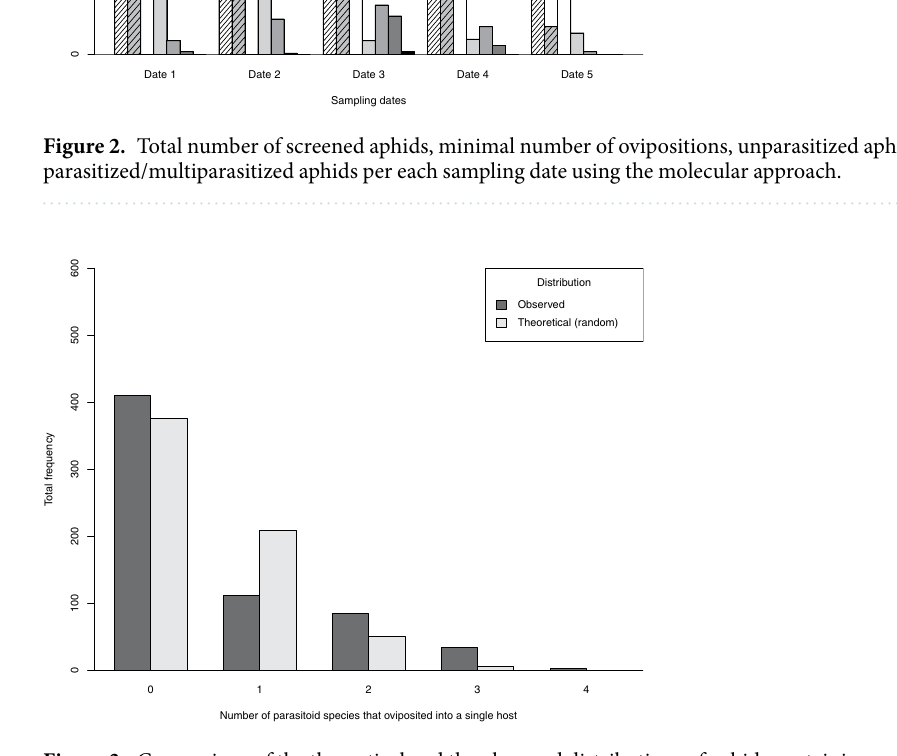
Figure 3. Comparison of the theoretical and the observed distributions of aphids containing zero to four parasitoid species. The theoretical distribution of zero, one, two, three and four parasitoid species in grey was calculated based on the total number of aphids collected during the season (641), parasitized by zero to four parasitoid species under the hypothesis of random host acceptance. The observed distribution of the number of parasitoid species, in black, was obtained by molecular detection of parasitoid DNA in these 641